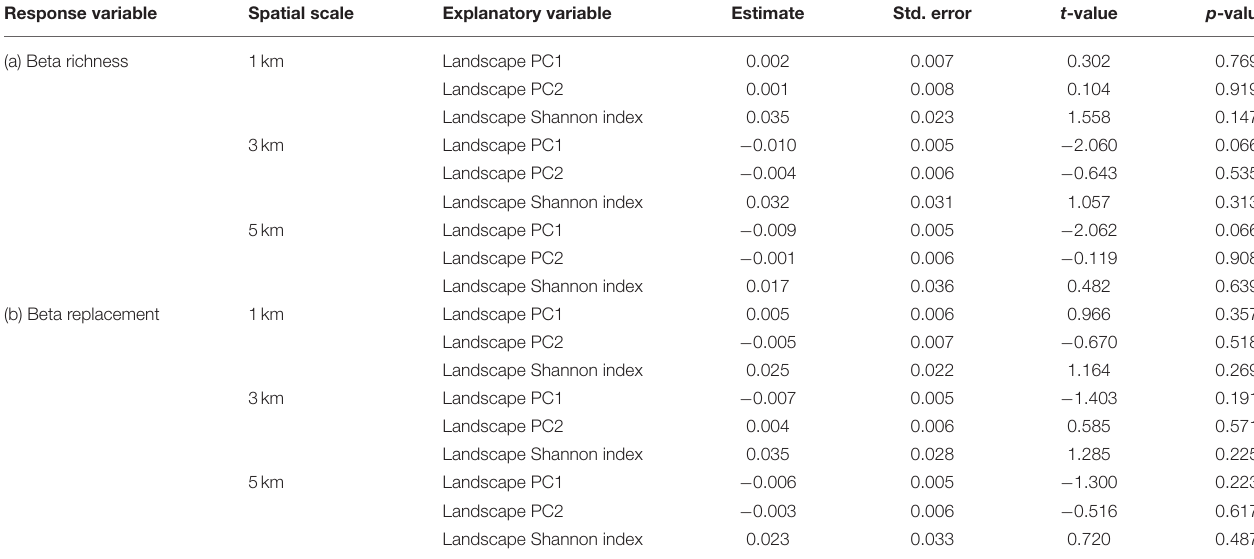
TABLE 2 | Results of the linear models testing the response of (a) mean beta richness and (b) mean beta replacement of pollen samples to PC1 and PC2 at the three spatial scales, i.e., 1km radius buffer, 3km radius buffer, and 5km radius buffer around the sampling locations. Response